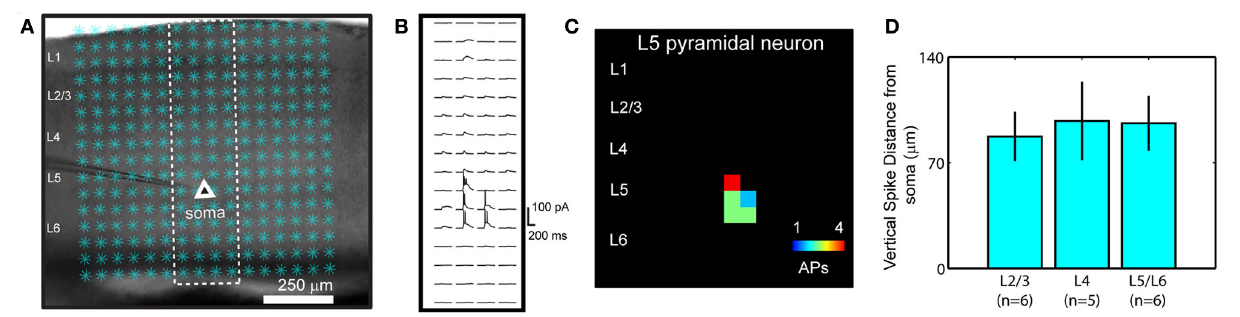
FIGURE A1 | Spatial precision of laser scanning photostimulation (LSPS). (A) Illustration from mapping a photostimulation-evoked excitation profile by recording a layer 5 neuron in the current clamp mode while photostimulation is delivered on the mapping grid (16 × 16 sites, each spaced at 65 μ m 2 ). The cell soma is indicated as a triangle. (B) Membrane potential traces in response to photostimulation at the white dashed box in A (4 × 16). Suprathreshold responses were evoked